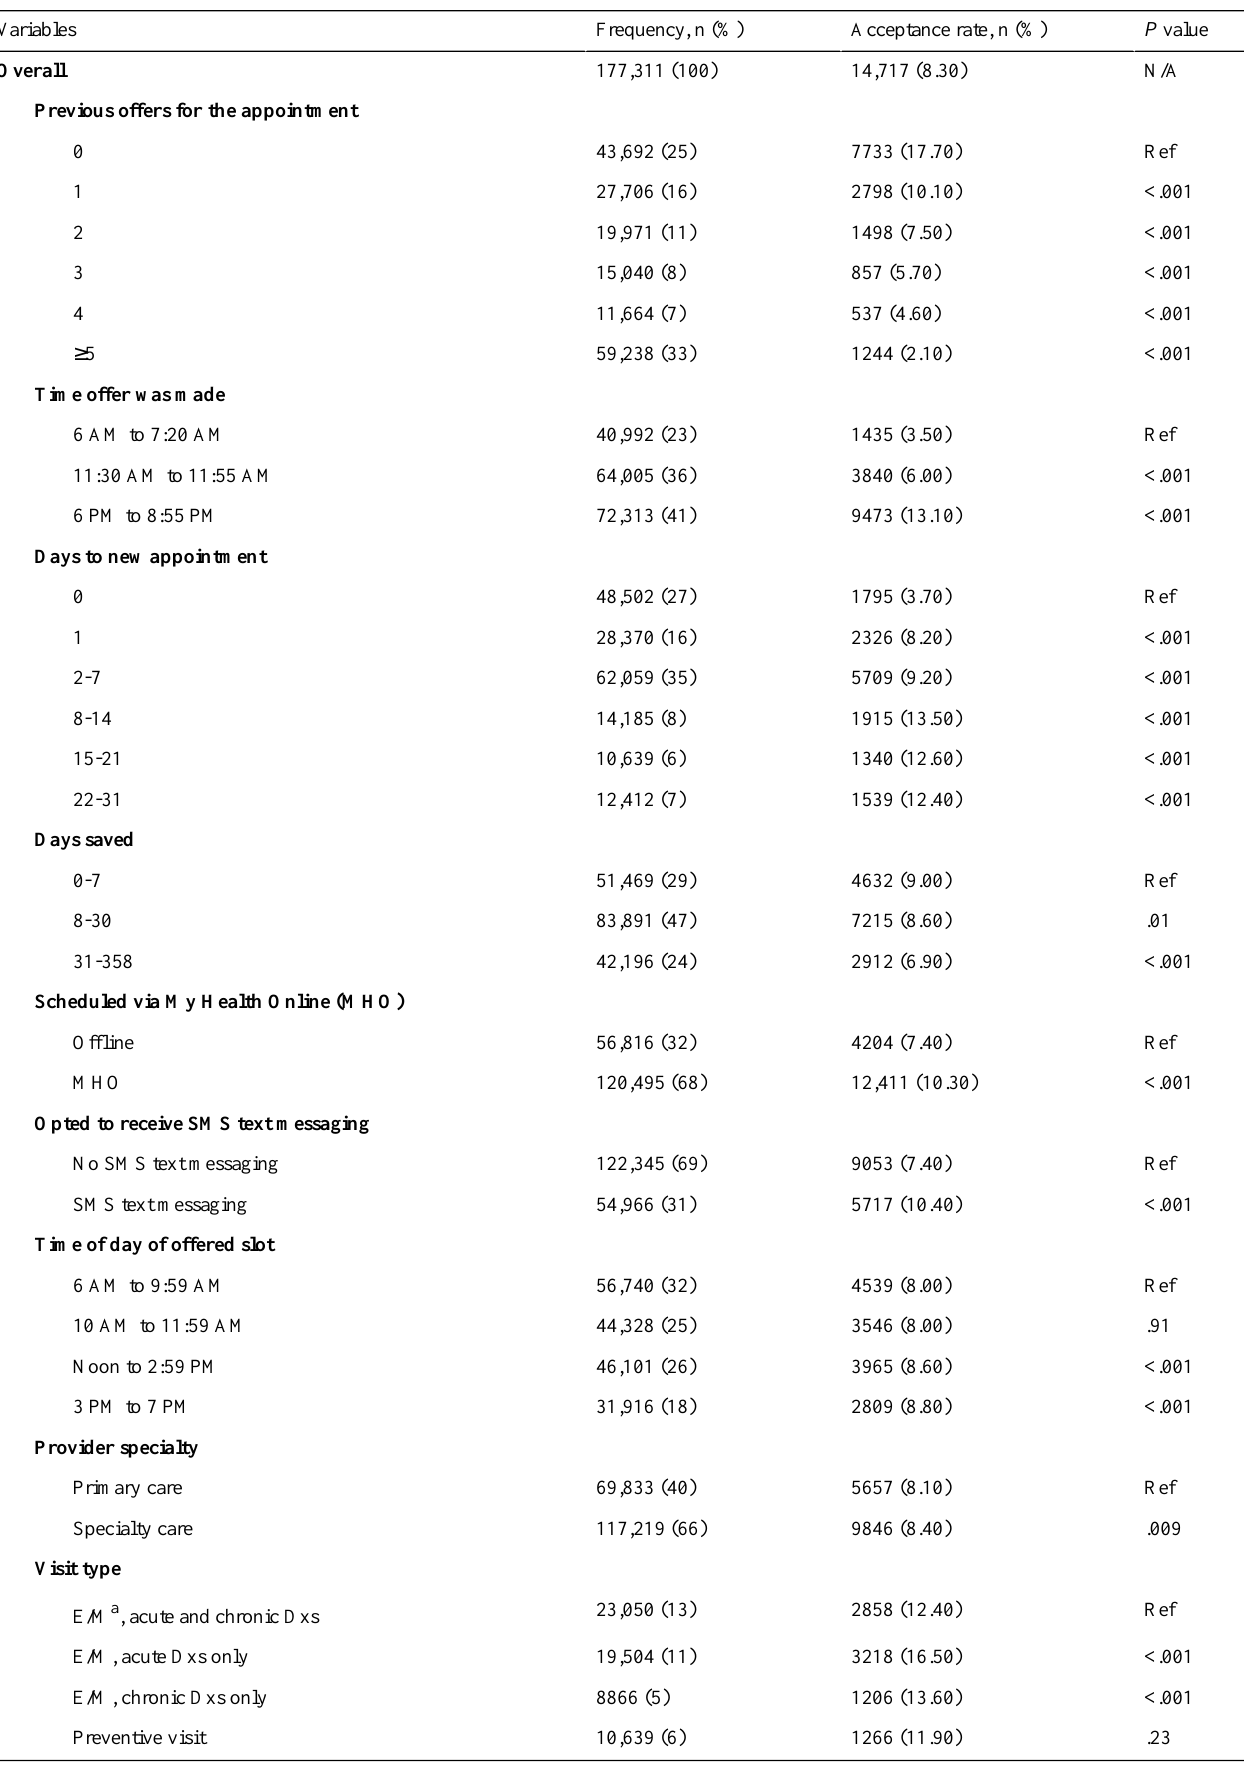
Table 2. Program, visit, and patient characteristics of Fast Pass offers.